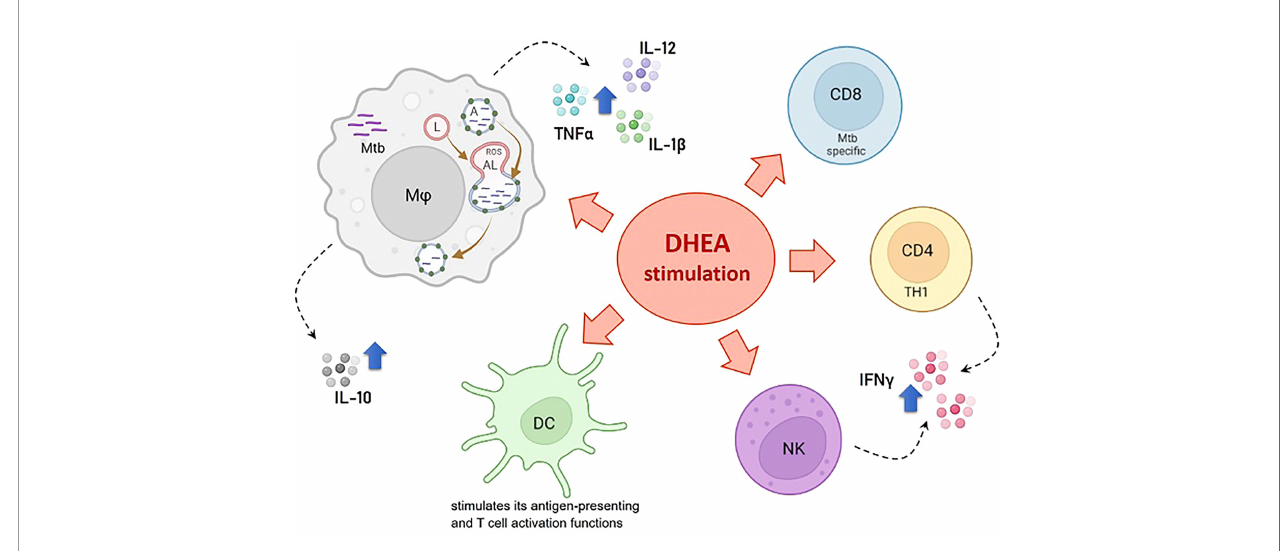
FIGURE 1 | Effects of DHEA on the anti-infectious immune response particularly against M. tuberculosis . References: M j , macrophage; DC, dendritic cell; NK, natural killer; CD4 TH1, CD4+ cells with the TH1 cell pro fi le; CD8, Mtb speci fi c CD8+ T cells; Mtb, M. tuberculosis ; ROS, reactive oxygen species; A, autophagosome; L, lysosome; AL, autophagolysosome. The blue arrow denotes stimulating